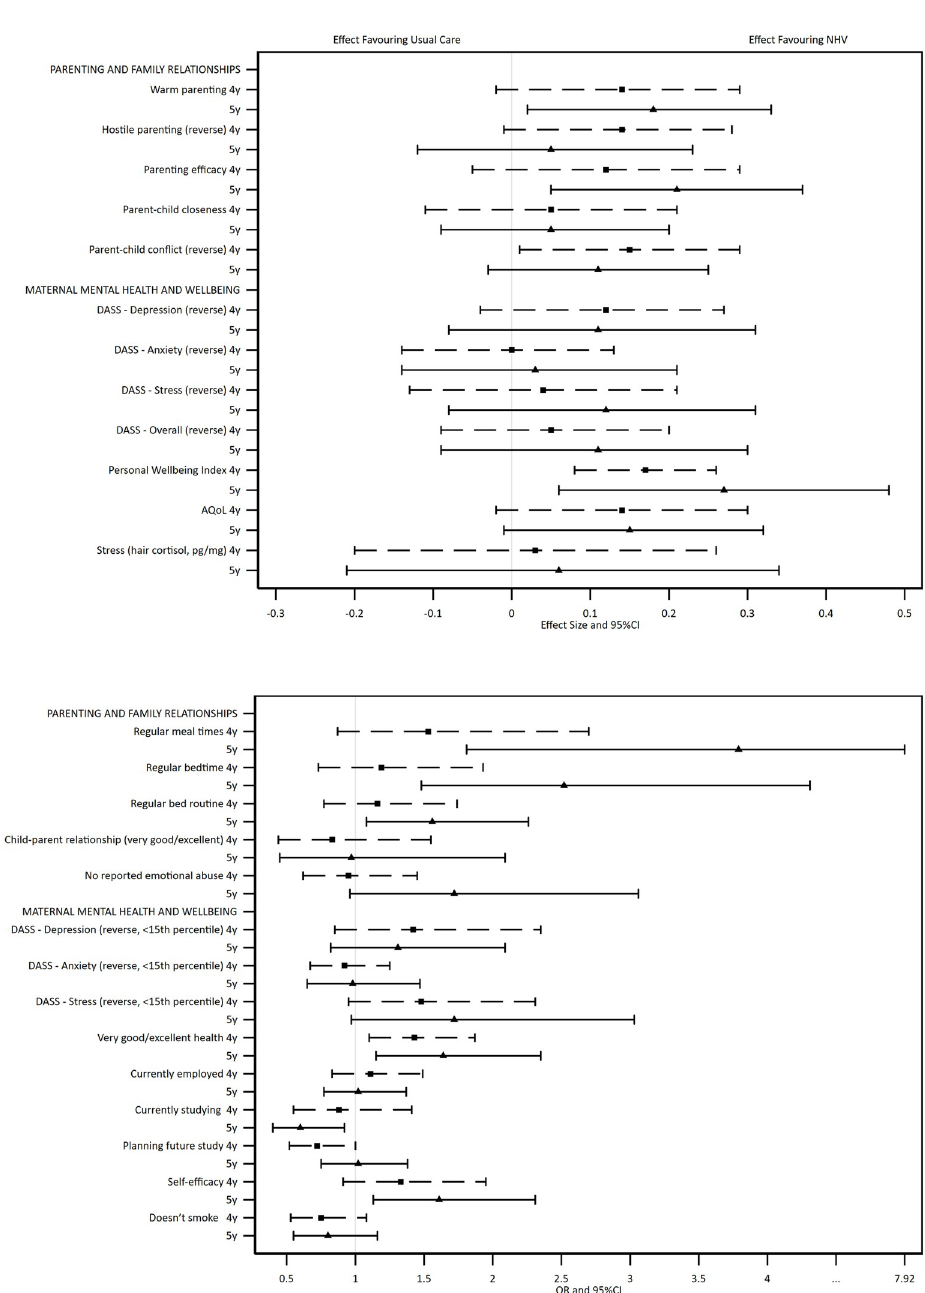
Fig 3. Results of adjusted regression analyses comparing the two trial arms on continuous (top box) and categorical (bottom box) maternal outcomes at 4 and 5 years, using multiply imputed and inverse probability weighted data.